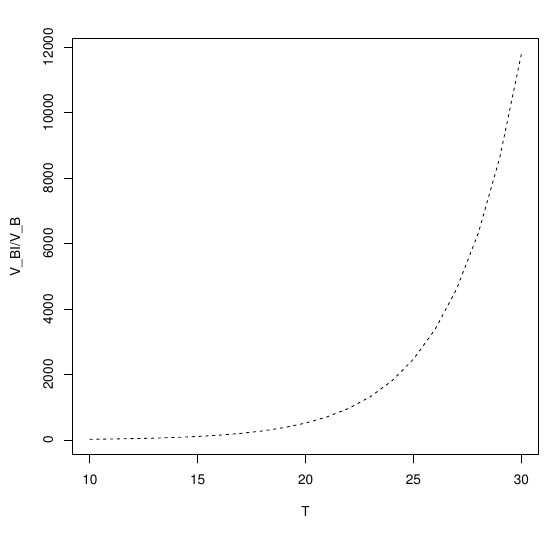
Figure 7. The impact of T